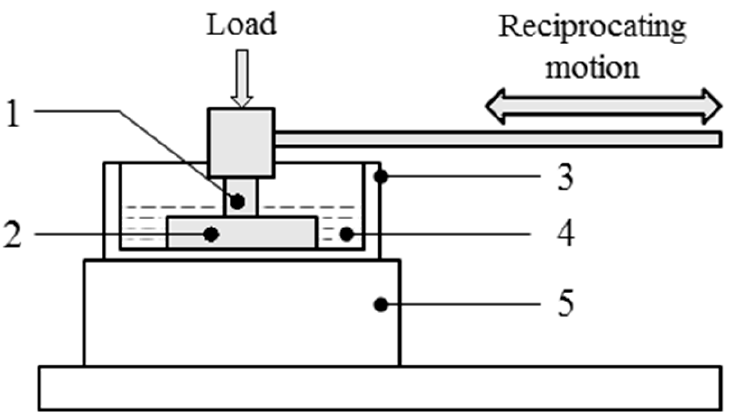
Figure 1. Experimental layout of TE77 tribometer. (1) PEEK upper specimen and mounted AE sensor, (2) steel lower specimen, (3) lubricant bath, (4) lubricant (ringer’s solution), (5) heater block.